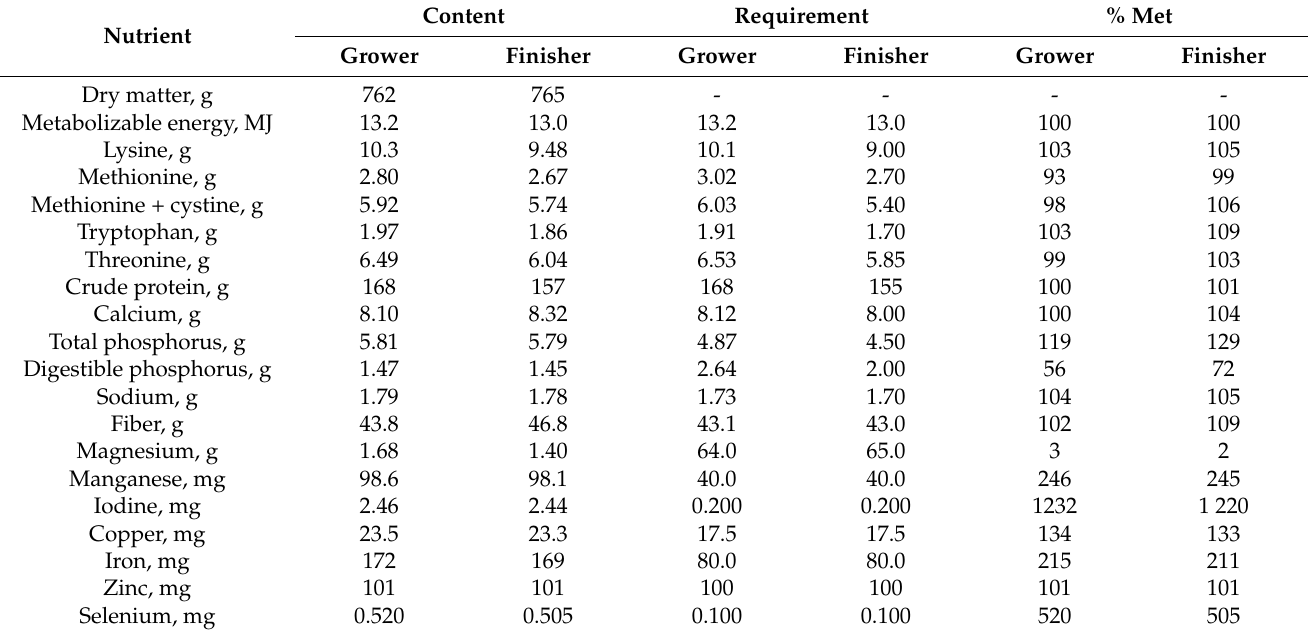
Table 2. Nutrient content in 1 kg grower feed 40–70 kg and finisher feed >70 kg body weight (BW); experiments 1 and